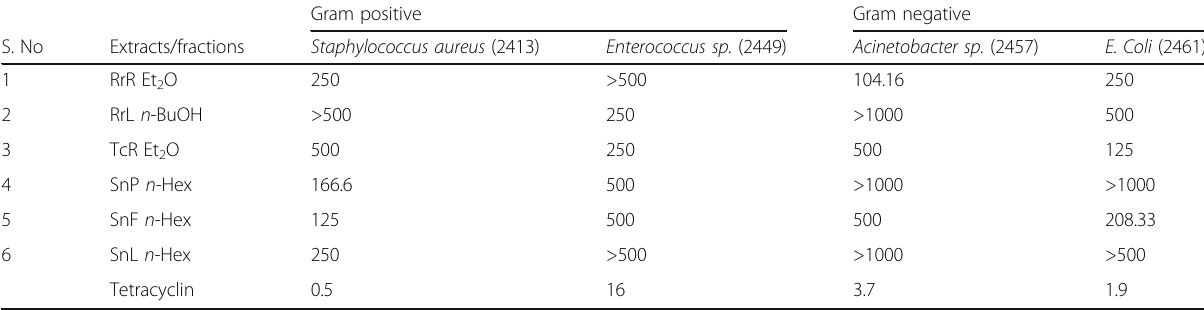
Table 8 Minimum Inhibitory Concentration (MIC a in μ g/mL) of the most potent fractions from three orchids